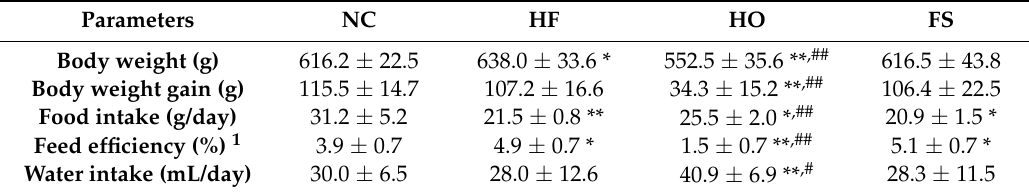
Table 2. The changes of body weight and food and water intakes in high fat (HF)-diet-fed rats supplemented with or without orlistat and resistant maltodextrin (RMD) for 8 weeks.